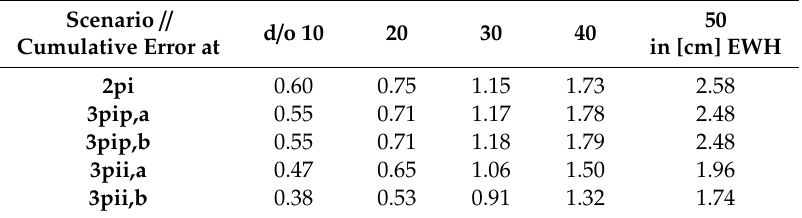
Figure 4. Double- vs. triple-pair scenarios (solution from 08/01/2002 to 14/01/2002). a) Coefficient differences of scenario 2pi (computed up to d/o 70), 3pip, and 3pii (computed up to d/o 90) with all sensors set to the NGGM noise. b) Spatial representation in terms of equivalent water heights (EWH) differences to the true solution up to d/o 50. Table 4. Cumulative error in cm EWH of scenarios at different maximum d/o from 10 to d/o 50 (latest crossing point of signal and error curve).